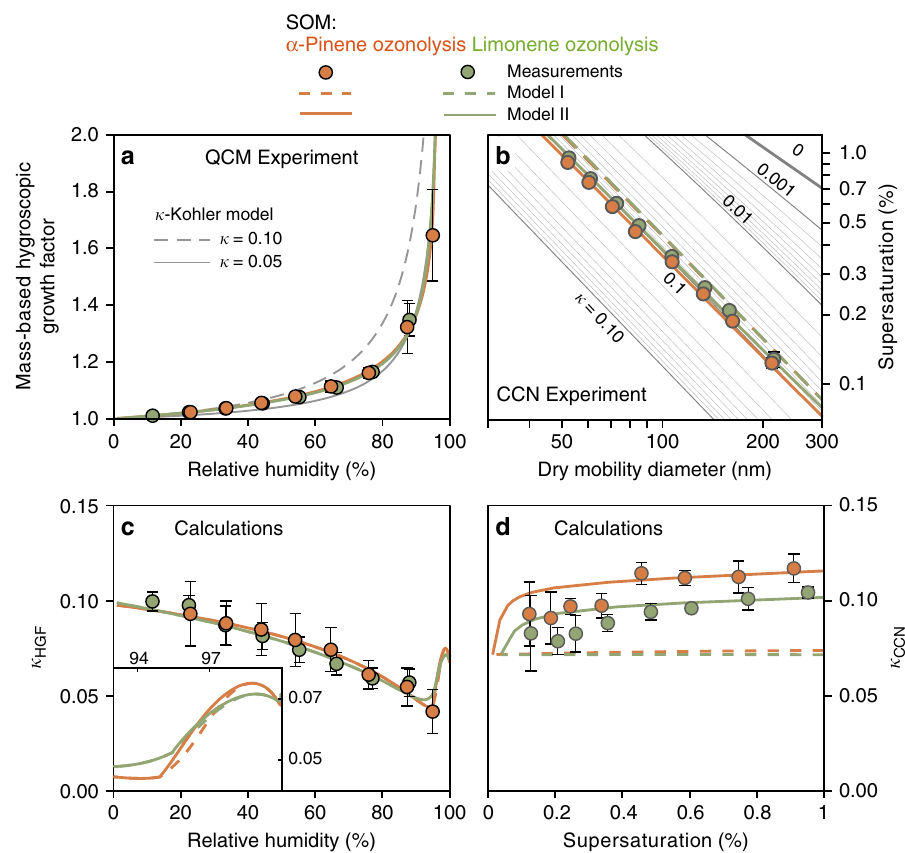
Fig. 1 Hygroscopic growth and CCN activity of secondary organic material derived from ozonolysis of biogenic monoterpenes. a Mass-based hygroscopic growth factors g m measured by the quartz crystal microbalance for different organic fi lms as a function of increasing relative humidity. b Critical supersaturation ratios s c (%) of CCN activation as a function of dry diameter d m,dry (nm). Gray lines in a , b show modeled results using constant κ values. c Hygroscopicity parameters κ HGF calculated from the data shown in a . d Effective hygroscopicity parameter κ CCN calculated based on the size-resolved CCN measurements for the surface tension value of pure water (0.072 N m − 1 ). Colored dashed and solid lines in a – d represent results of Model I (single-phase model) and Model II (LLPS model), respectively (see main text). In a , dashed lines of Model I are hidden behind the solid lines of Model II because two models yield identical results in the absence of LLPS (RH < 95%). For clarity, model lines for κ HGF at high RH are shown in the inset of